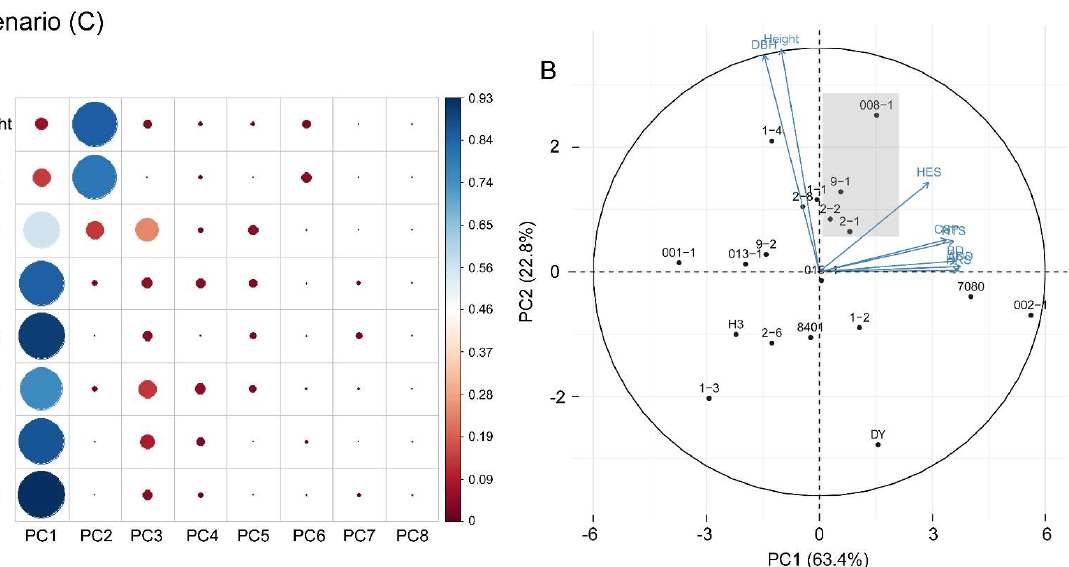
Figure 3. Principal component analysis of the growth traits and wood properties of Catalpa bungei clones. ( A ): The representation of the principal components for the traits. ( B ): The principal component score biplot based on PC1 and PC2.